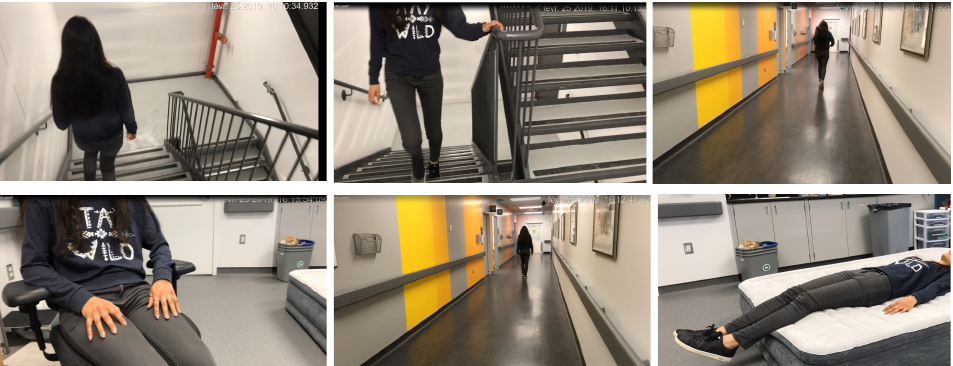
Figure 2. Experimental setup showing some of the performed physical activities in our research protocol: going down stairs, going up stairs, running, sitting, walking, and lying